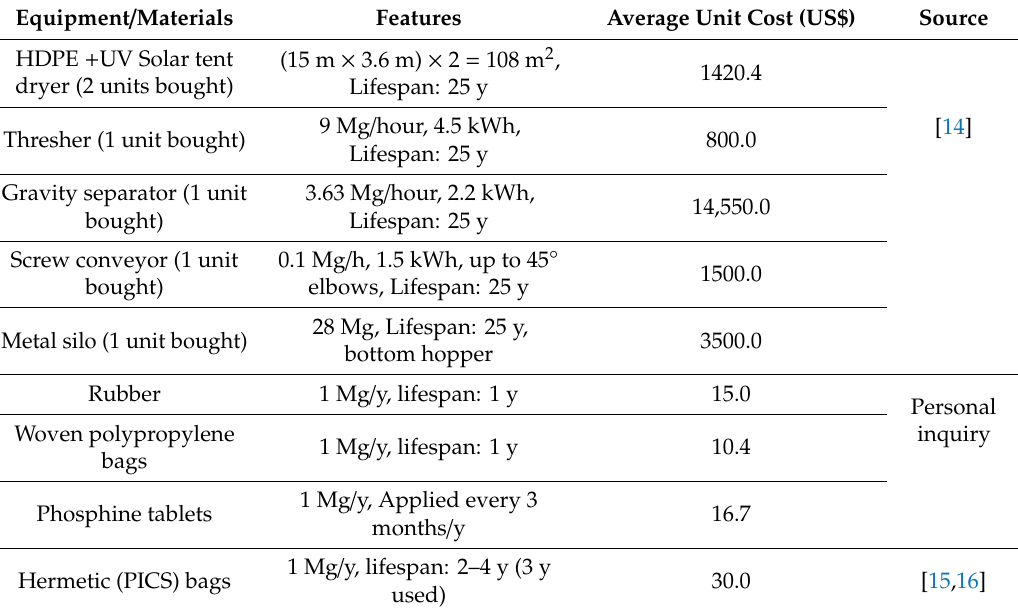
Table 2. Specifications and prices of equipment and materials used for the cost analysis.